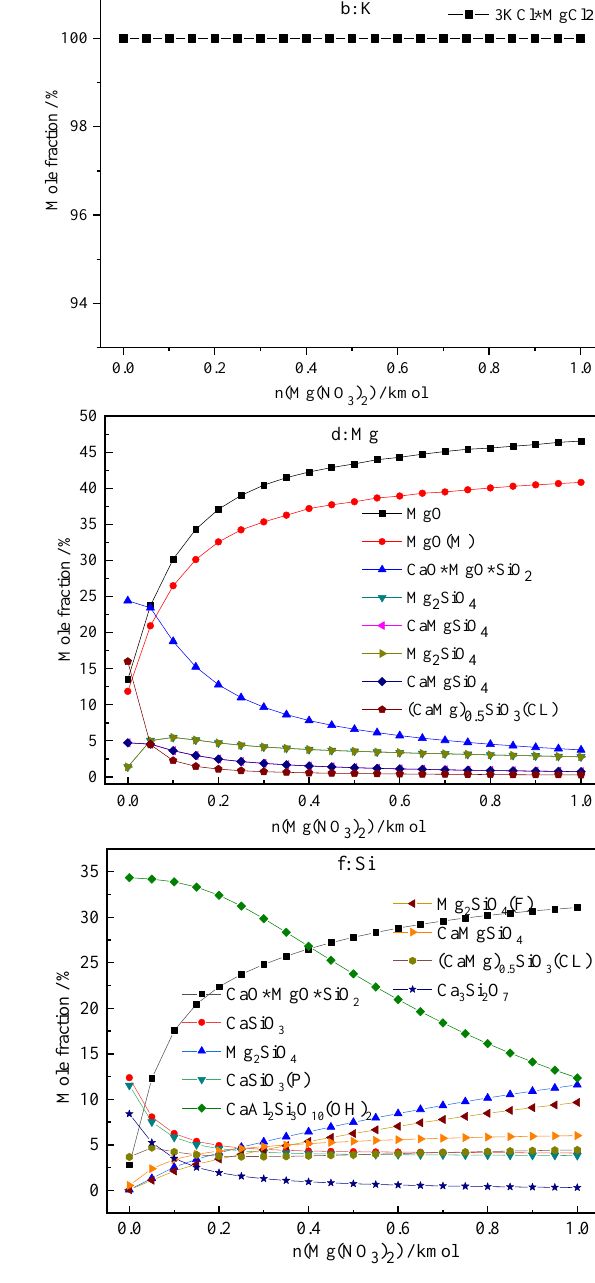
Figure 3. Effect of the amount of Mg(NO 3 ) 2 addition on the migration and transformation of main elements in ash. ( a ): Na, ( b ): K, ( c ): Ca, ( d ): Mg, ( e ): Cl, ( f ): Si. The asterisk in the chemical formula shows that the molecules or species are attached with each other as independent species, similarly